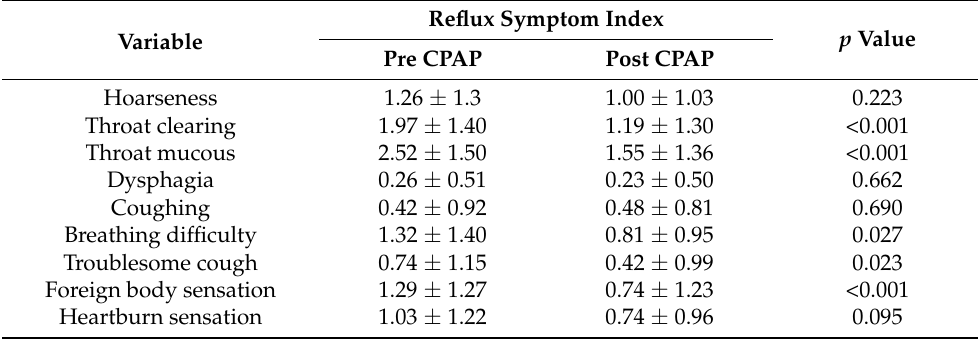
Table 4. Comparison of individual reflux symptom index subdomains before and after CPAP treatment.